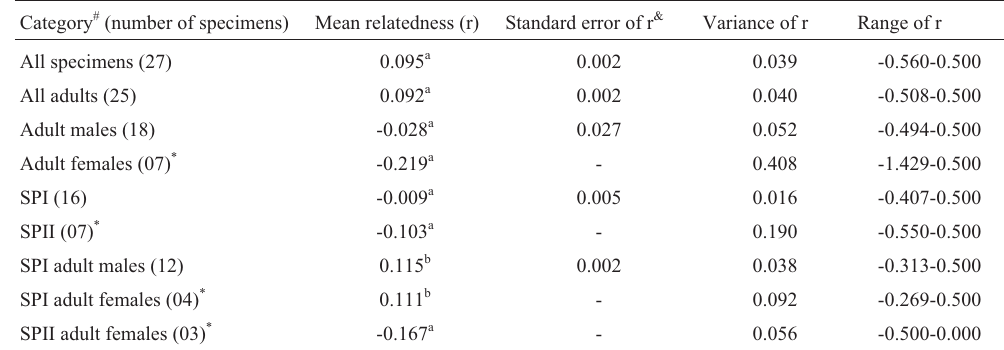
Table 2 - Mean relatedness, by category, between Myrmecophaga tridactyla specimens sampled at Emas National Park, Brazil. Category # (number of